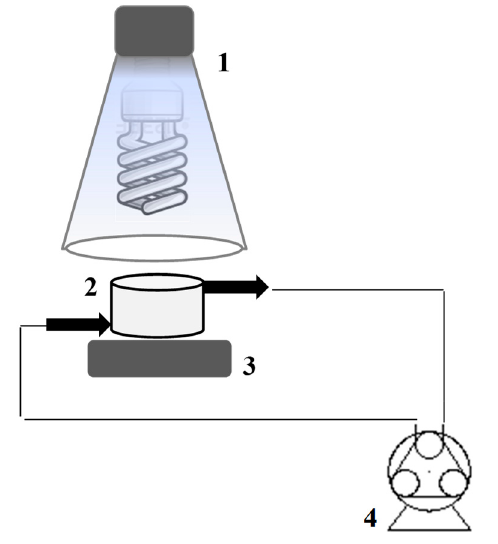
Figure 8. Scheme of the experimental set-up used for the photocatalytic degradation experiments; 1—irradiation source with reflective surface, 2—photocatalytic cell (dcell = 45 mm, reaction mixture level = 24 mm), 3—magnetic stirrer, and 4—peristaltic